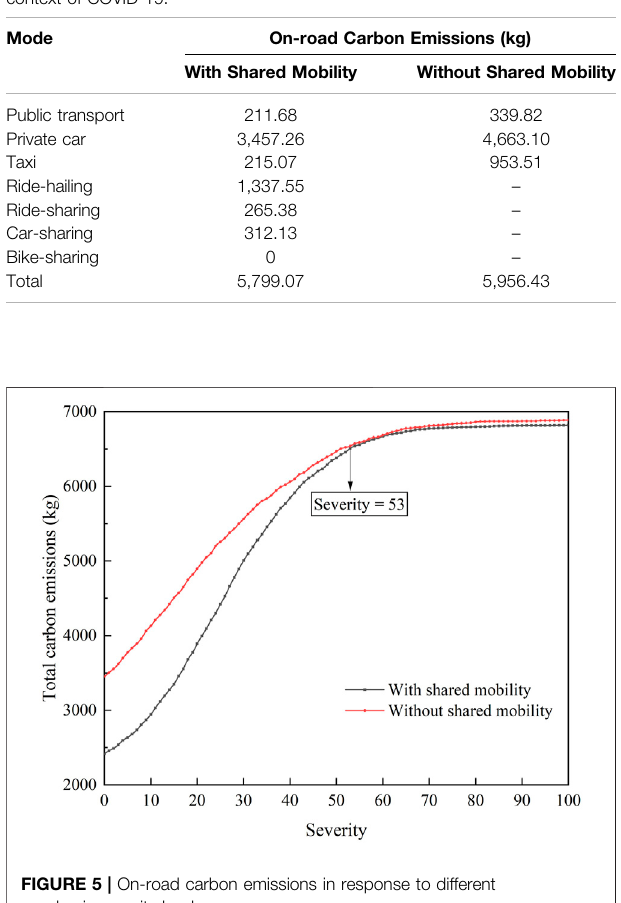
FIGURE 5 | On-road carbon emissions in response to different pandemic severity